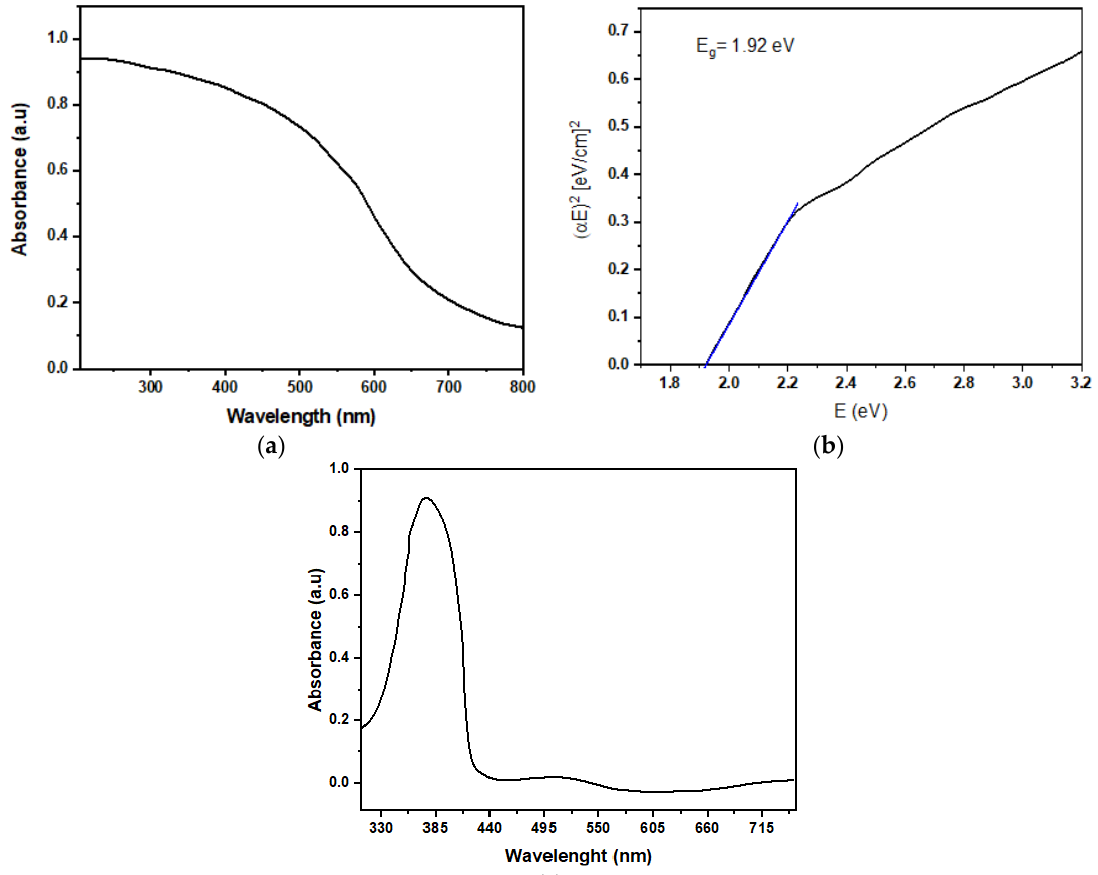
Figure 5. ( a ) UV-Vis spectrum and ( b ) Tauc’s plot of Cu 2 O nanoparticles ( c ) UV-vis spectrum of F8